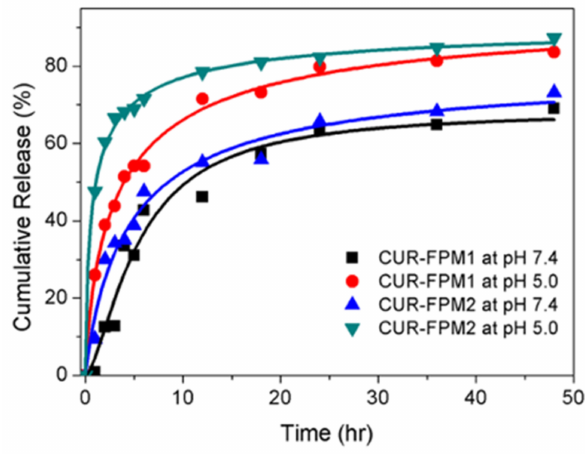
Figure 2. Cumulative CUR release from the CUR-FPM1 and CUR-FPM2 micelles at di ff erent pH